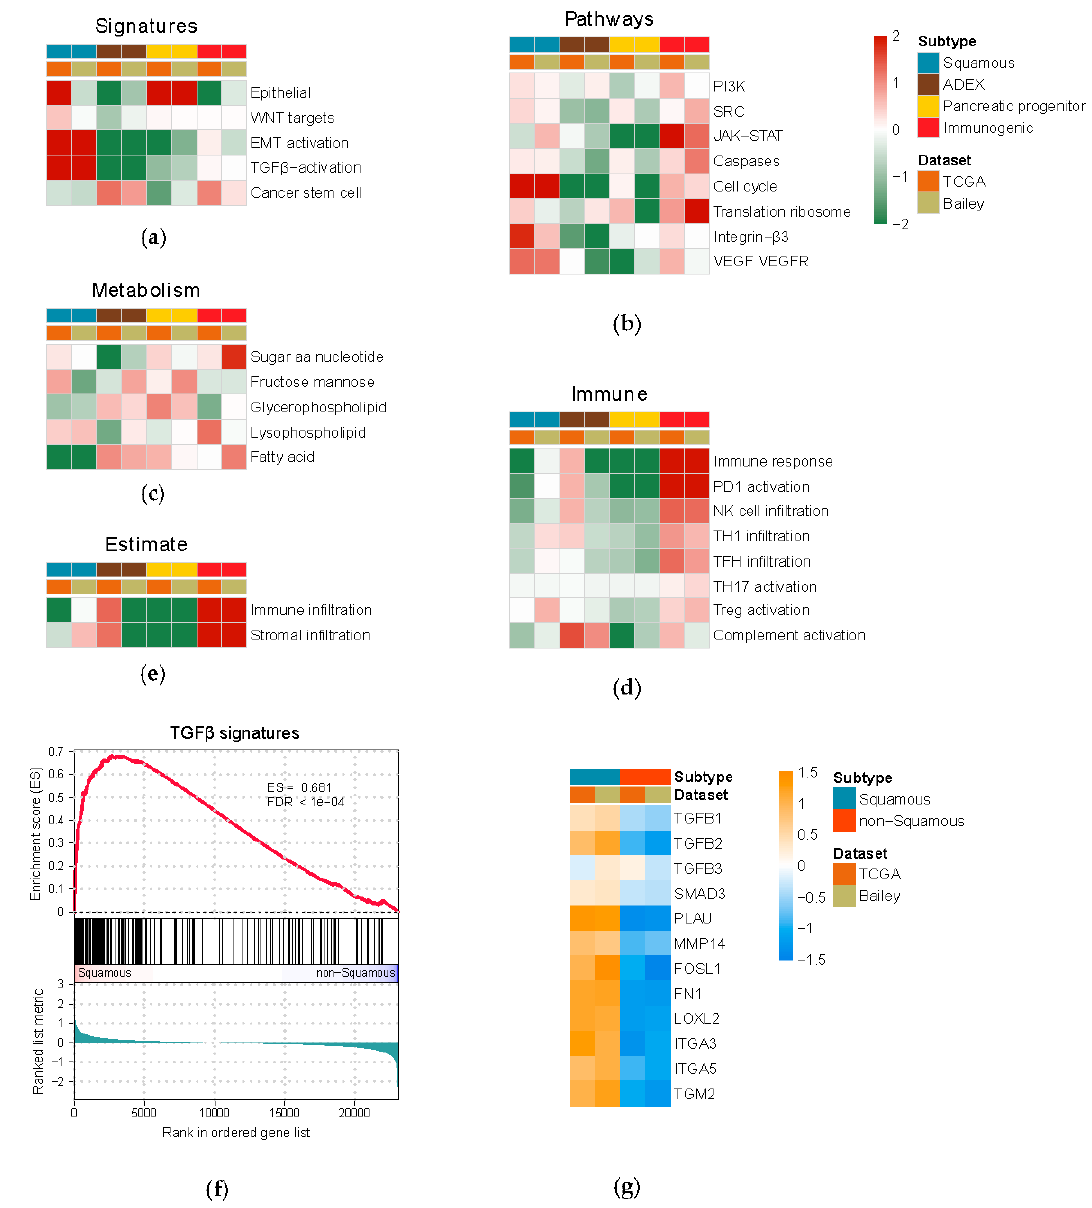
Figure 2. A landscape of molecular properties associated with PDAC subtypes. ( a–e ) Heatmaps illustrating gene set enrichment analysis on canonical signatures and pathways, metabolic pathways, immune signatures as well as immune and stromal contents calculated by ESTIMATE [33] ( n = 149, TCGA dataset; n = 70, Bailey dataset). Red color represents over enrichment and green represents under enrichment; the depth of color is proportionate to − log 10 ( p -value) of GSEA. ( f ) Gene set enrichment analysis (GSEA) showed TGF β signature genes are significantly up-regulated in the squamous subtype in TCGA dataset. ( g ) Heatmap showing the average log 2 fold change of key TGF β signature genes between squamous and non-squamous subtype in both TCGA and Bailey data set.